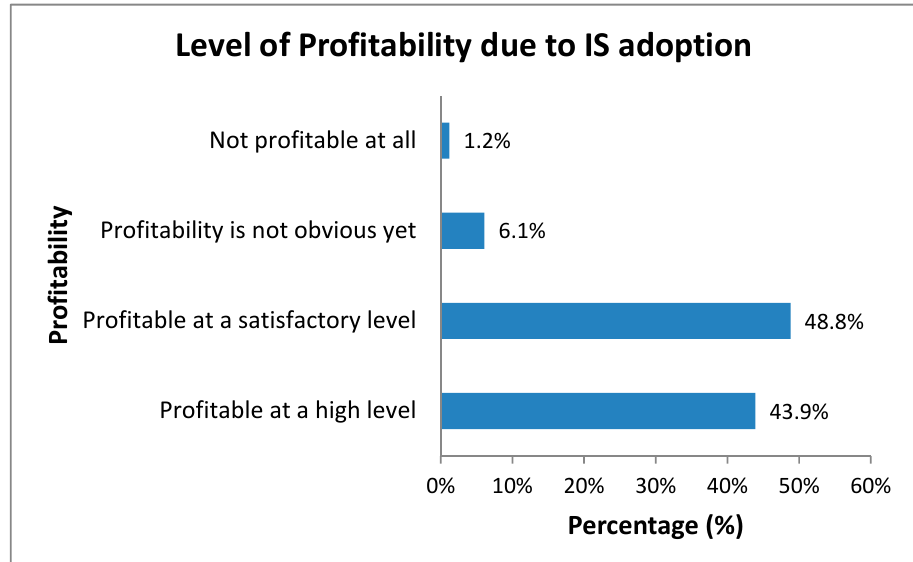
Figure 3. Level of profitability due to IS adoption.